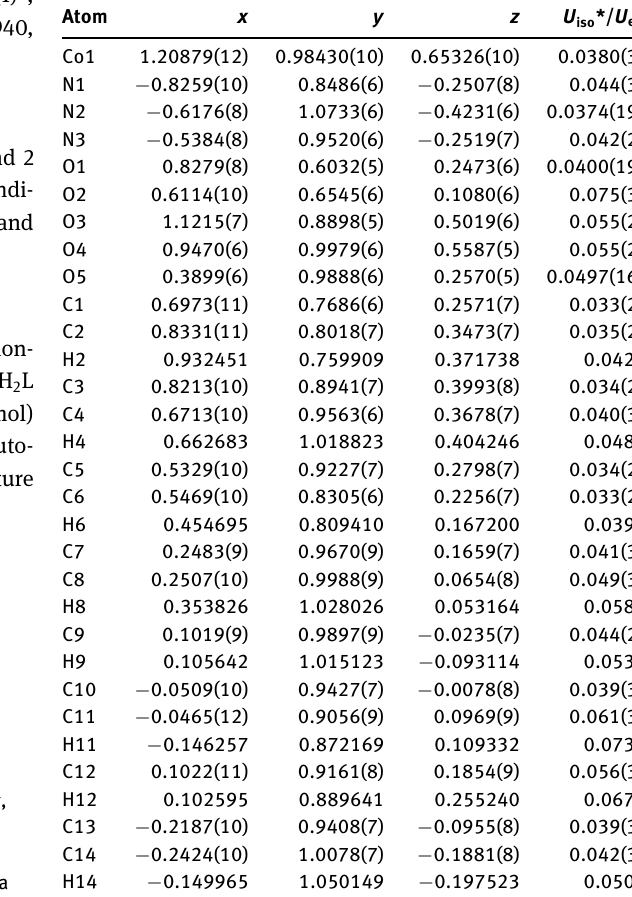
Table 2: Fractional atomic coordinates and isotropic or equivalent isotropic displacement parameters (Å 2